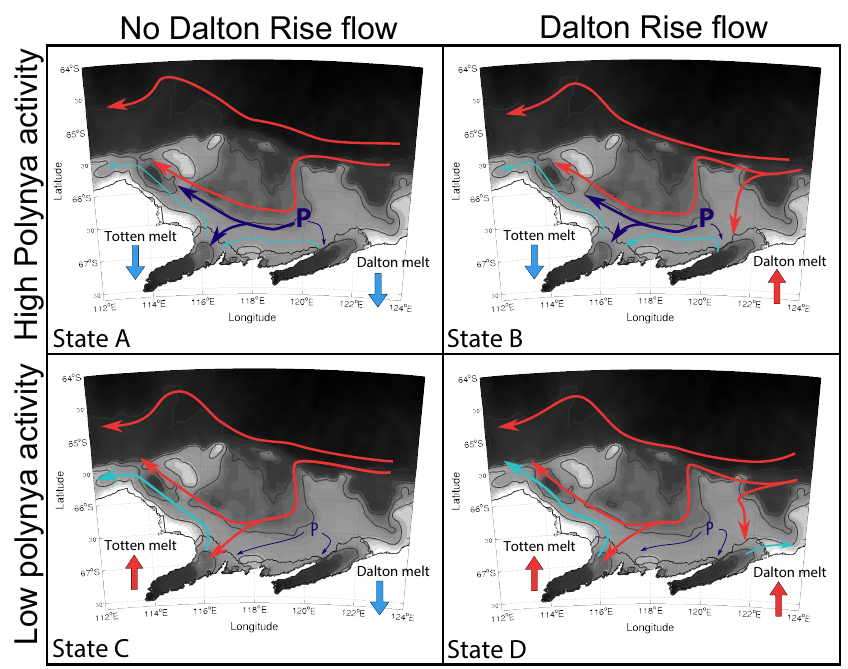
Fig. 6. ASC (light red line), HSSW (dark blue line) and ice shelf meltwater (light blue line) are shown for; States (A) : here, polynya activity is strong (as shown by a bold “P”), but the ASC only enters the Totten basin. Consequently, both ice shelves show lowered melt rates. (B) : polynya activity is strong, however the ASC comes onshore on both sides of the Dalton rise, leading to increased Dalton ice shelf melt rates. HSSW produced by the polynya and Dalton ice shelf melt water combine to lower Totten melt rates. (C) : polynya activity is weak (as shown by a thinner “P”) and warm water only flows into the Totten basin. Consequently, the Totten ice shelf displays strong melting, while the Dalton ice shelf displays weak melting. (D) : polynya activity is weak and warm water onflow over the Dalton rise and into the Totten basin lead to high melt rates for both ice